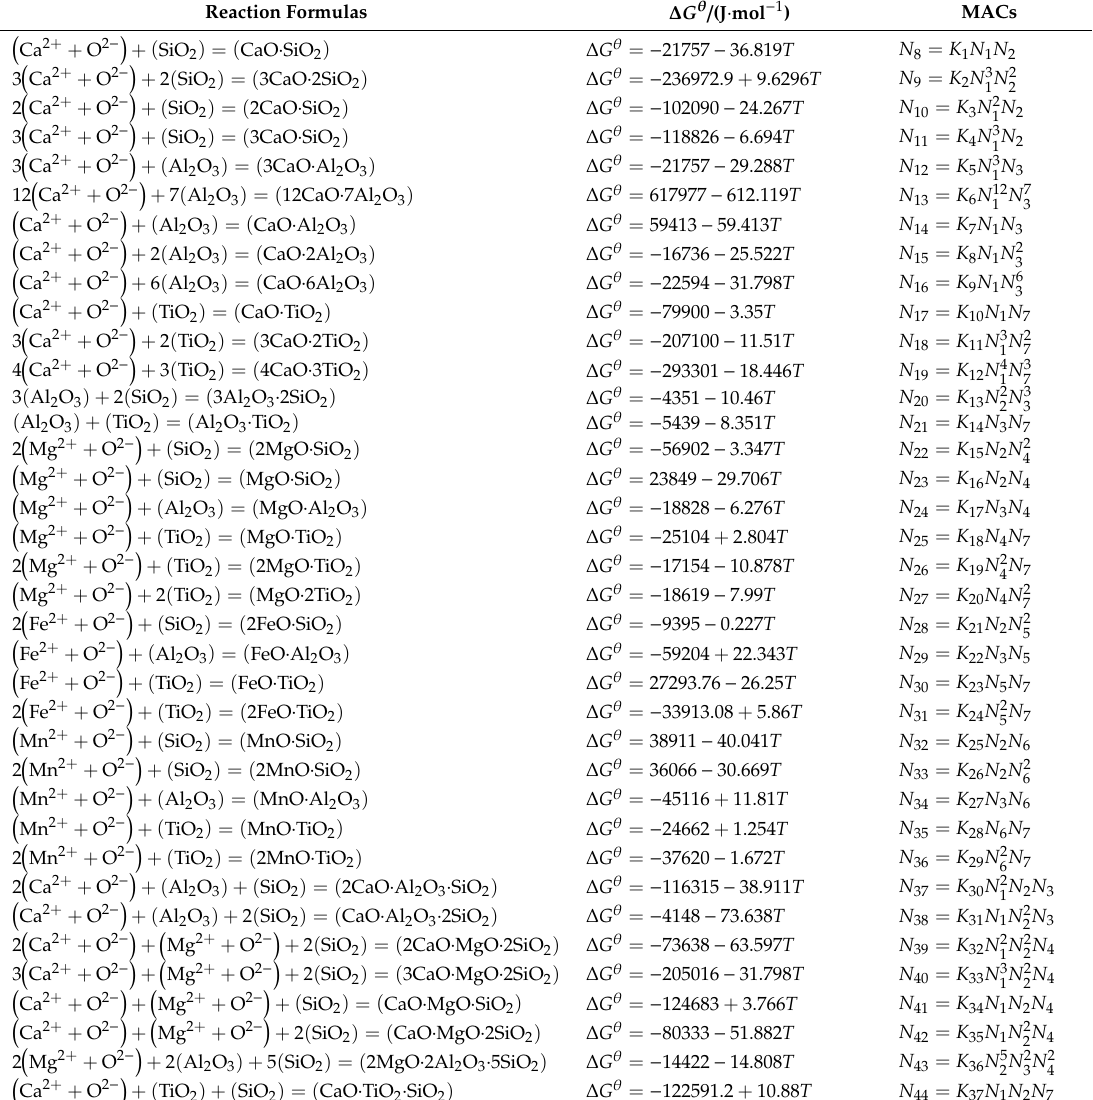
Table 4. Reaction formulas, Gibbs free energies, and mass action–concentrations (MACs) [26–32]. Reaction